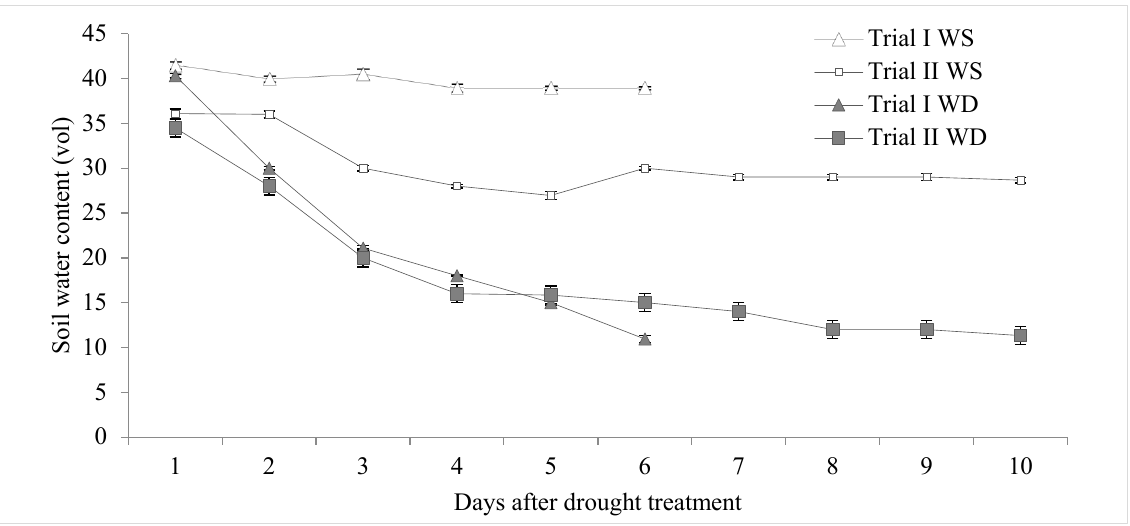
Figure 1. Soil volumetric content (% vol) of water-sufficient (WS) and water-deficient (WD) treatments in Trial I and Trial II. Values represented are the mean of 44 A. tricolor accessions in Trial I (N = 3) and Trial II (N = 4), and error bars represent the standard error of the mean